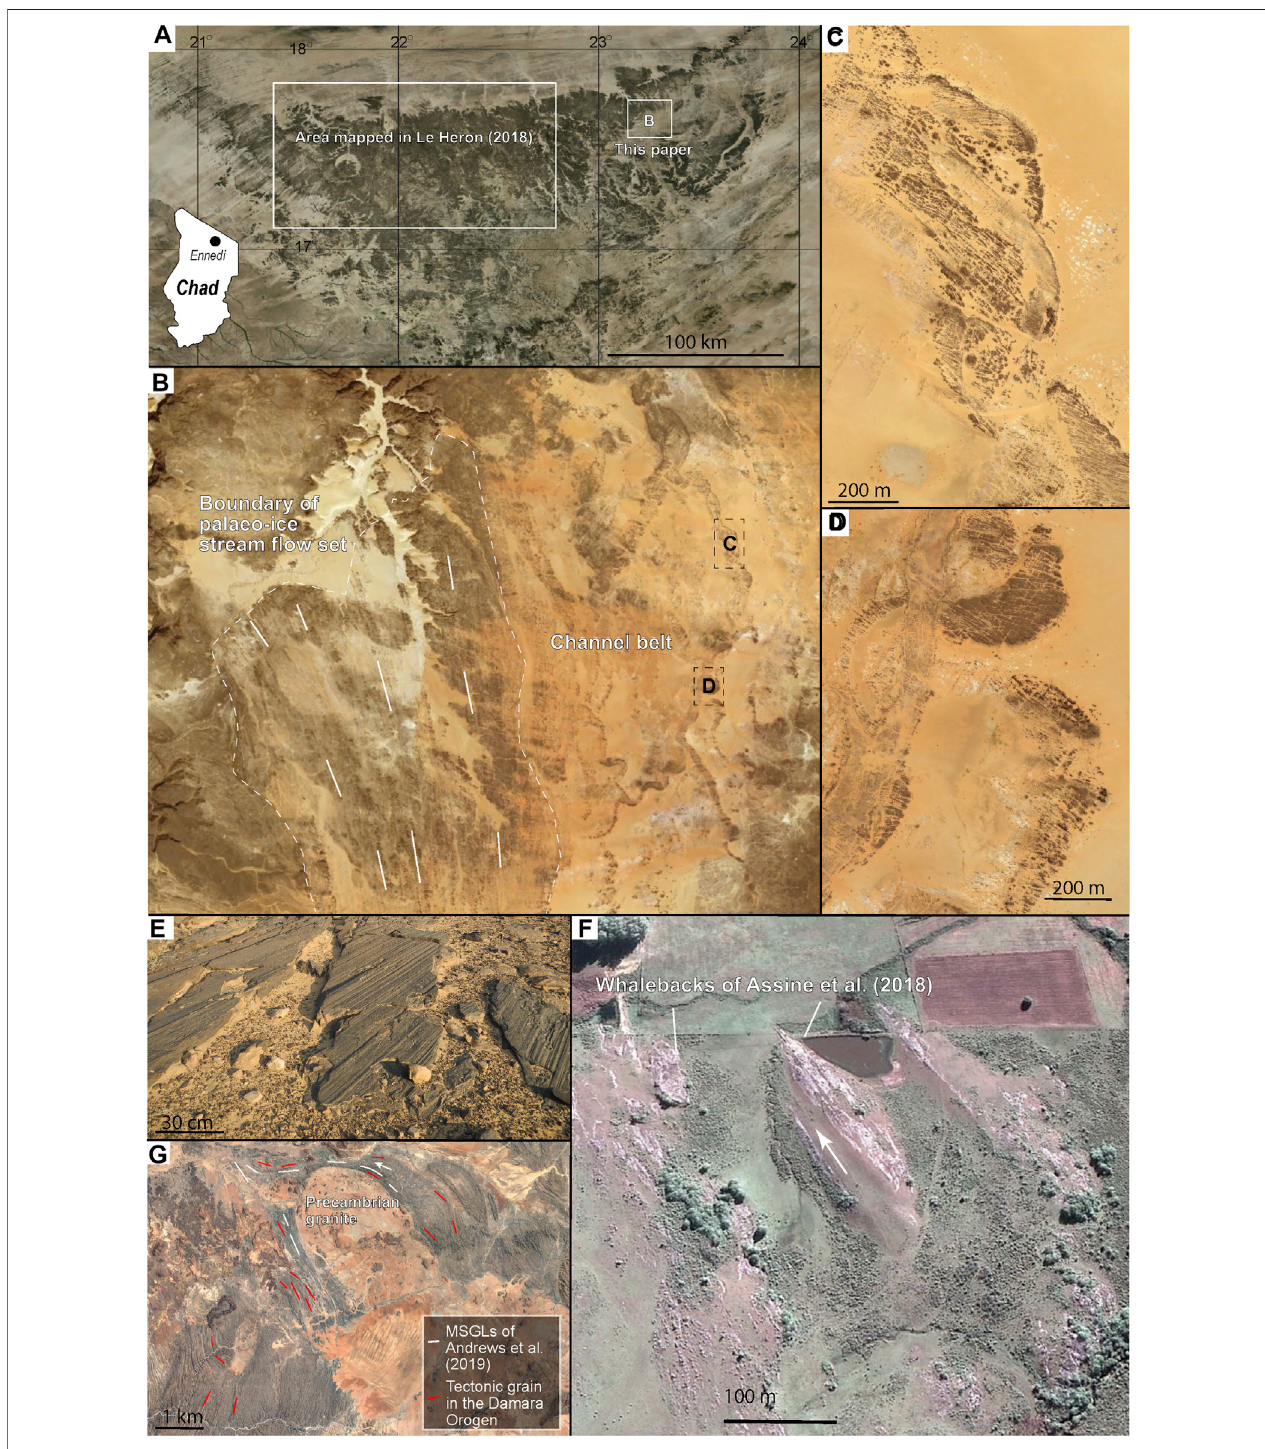
FIGURE 3 | The interpretation of Late Palaeozoic Ice Age (LPIA) glacial land surfaces from satellite data. (A) The Ennedi plateaux of northern Chad, showing the mappedlocationofthepalaeo-icestreamnetworkdocumentedinLeHeron(2018),anditseastwardcontinuation(thisstudy). (B) Interpretedpalaeo-icestream fl owset withmega-scale glaciallineations (MGSLs)totheleftoftheimage, andanextensivechannelbelttotheright. Thelocationoftheimages (C,D) arehighlightedinthesmall rectangles. (E) Soft-sediment striations at outcrop in the Ennedi plateaux. Image courtesy of Ursula Steiner, whose photo was taken at 17.623 ° N 22.777 ° E. (F) GoogleEarthimageofwhalebackspublishedinAssineetal.(2018)-hardbedrockstructuresintheLPIAofnorthernUruguay.SeeAssineetal.(2018)forpreciselocation information. (G) ThezoneoftheDamaraOrogen,centralNamibia,featuredinAndrewsetal.(2019).TheseauthorsinterpretedMGSLs,yetherewecautionthattheseare paralleltothetectonicgrainoftheorogen,underscoringthattheutmostcaremustbetakingwhenmappingandinterpretingdeeptimeglaciallandsurfacesfromsatellite imagery. See Andrews et al. (2019) for precise location information.